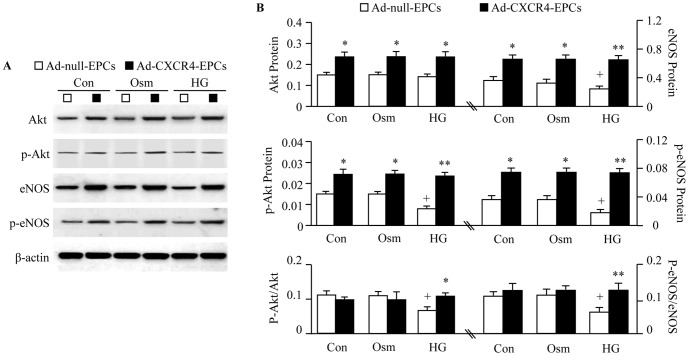
Ad-CXCR4 transfection protects down-regulation of Akt/eNOS activation in EPCs induced by HG.(A) Representative western blot bands showing Akt/eNOS and p-Akt/p-eNOS expression in different treatment groups. The molecular weights are 60 kDa for Akt and p-Akt, and 140 kDa for eNOS and p-eNOS. (B) Summarized data on Akt/eNOS and p-Akt/p-eNOS expression in EPCs of different treatment groups, *P<0.05, **P<0.01 vs. Ad-null-EPCs; ++
P<0.01 vs. Con or Osm. Con: control (basal medium); Osm: osmotic control; HG: high glucose medium; p-Akt: phosphorylated Akt; p-eNOS: phosphorylated eNOS; PI3K: phosphatidylinositol-3-kinase; NOS: nitric oxide synthase; Ad-null-EPCs: EPCs transfected with Ad-null; Ad-CXCR4-EPCs: EPCs transfected with Ad-CXCR4.